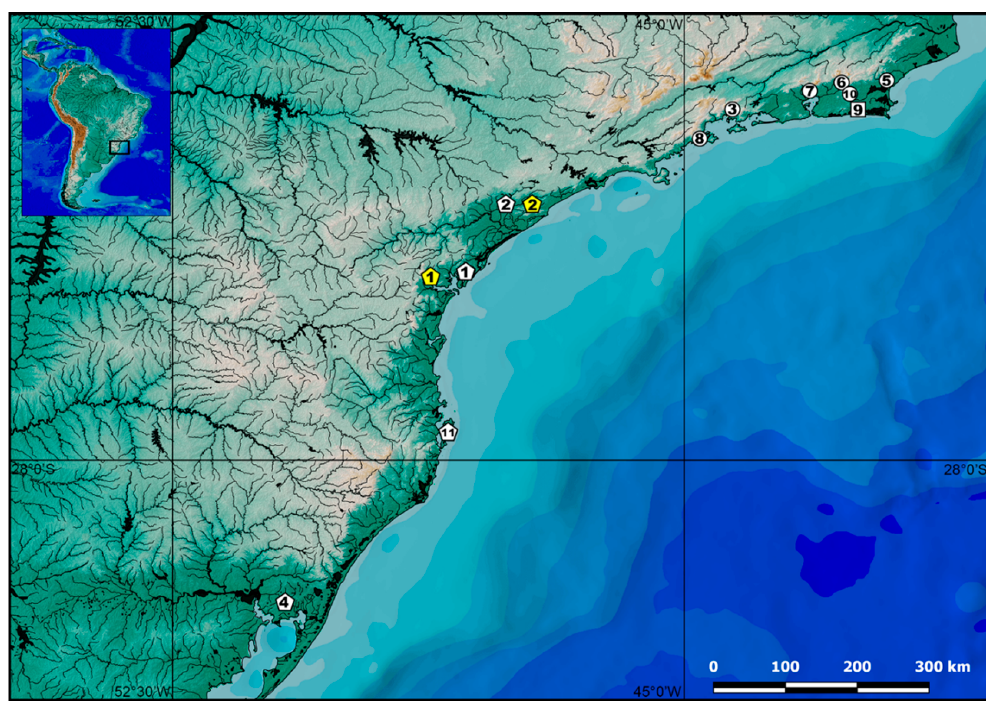
Figure 2. Geographical distribution of species of the genus Listrura . Circles indicate species of the subgenus Listrura ; square, species of the subgenus Paralistrura ; and pentagons, species of the subgenus Prolistrura . 1, L. boticarioi ; 2, L. camposi ; 3, L. costai ; 4, L. depinnai ; 5, L. macaensis sp. nov.; 6, L. macacuensis sp. nov.; 7, L. nematopteryx ; 8, L. picinguabae ; 9, L. tetraradiata ; 10, Listrura sp. 2; 11, Listrura sp. 1. White symbols are type localities.